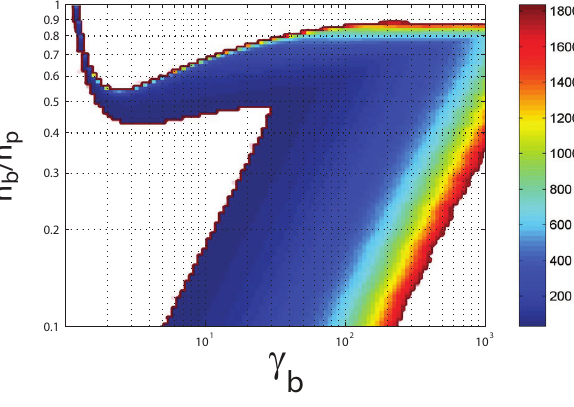
Fig. 6. Critical mass ratio for the system described in Sect.